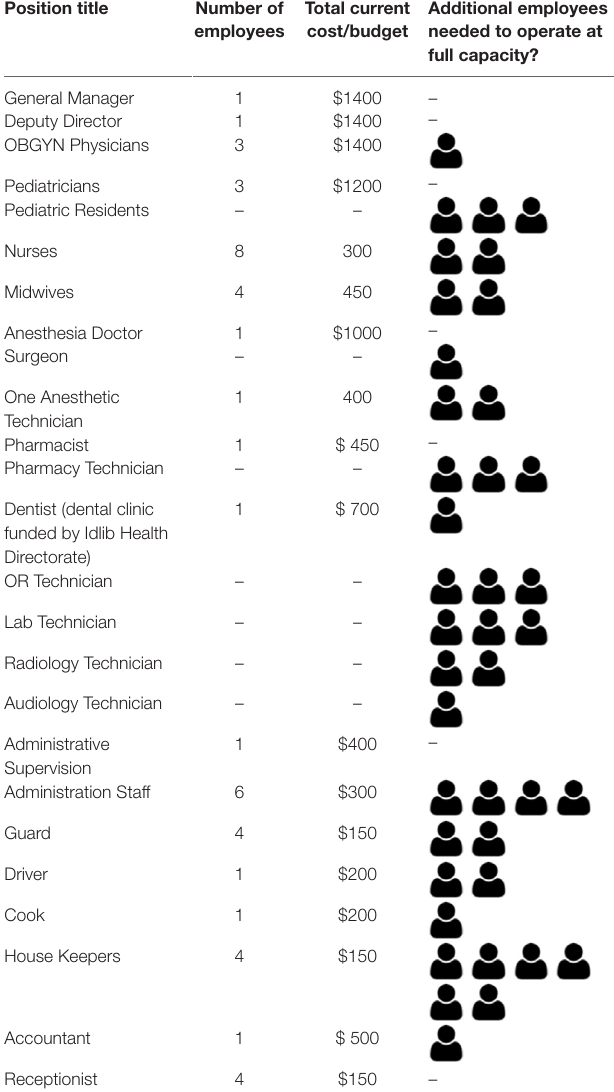
taBLe 2 | Workforce and associated monthly costs compared to additional employees needed to operate at full capacity for 2017 (all in US